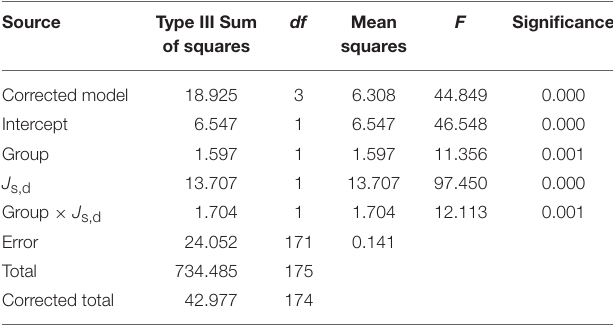
TABLE 5 | ANCOVA results of the effects of group, J s,d (daytime sap flux) or the interaction of group and J s,d on J s,n (nighttime sap flux). df Mean F Source Type III Sum of squares squares